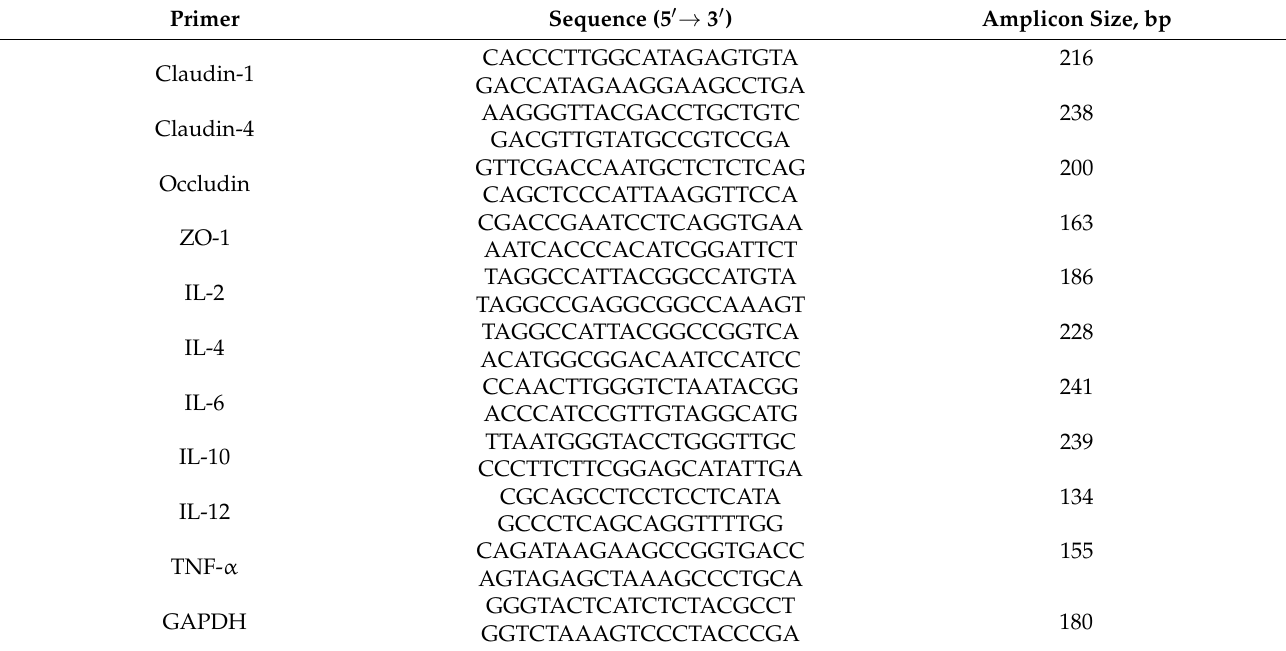
Table 2. Gene-specific sequence primers used in real-time quantitative PCR.